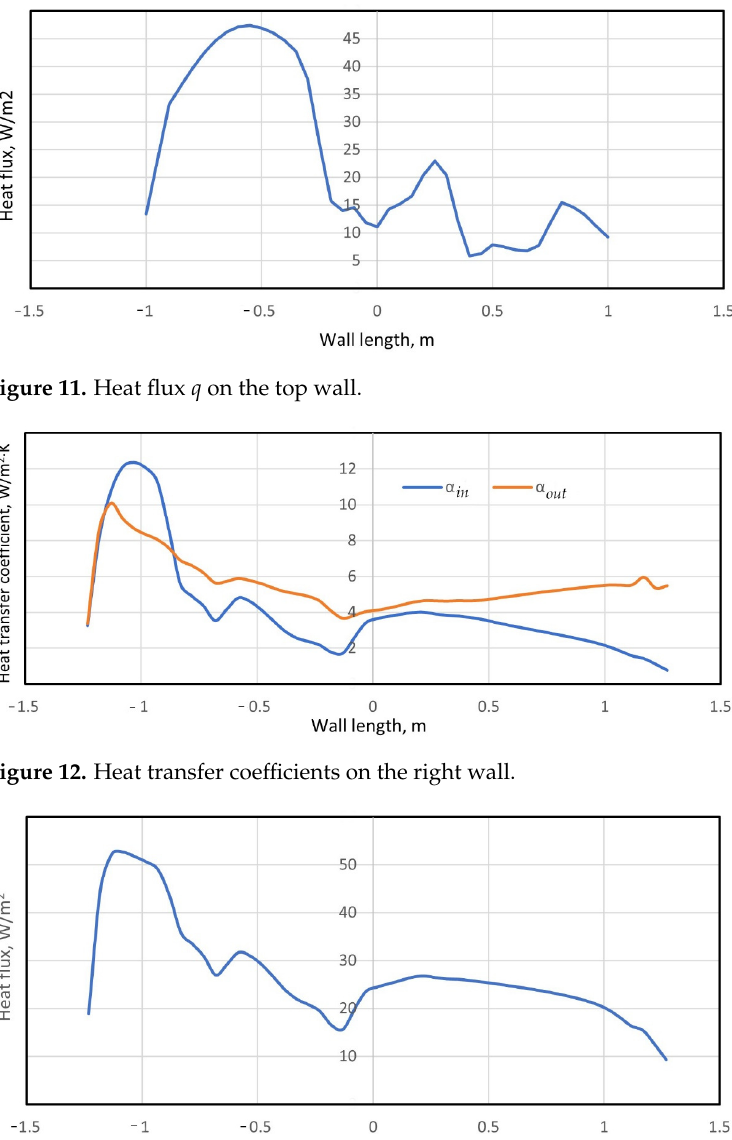
Figure 10. Heat transfer coefficients on the top wall.